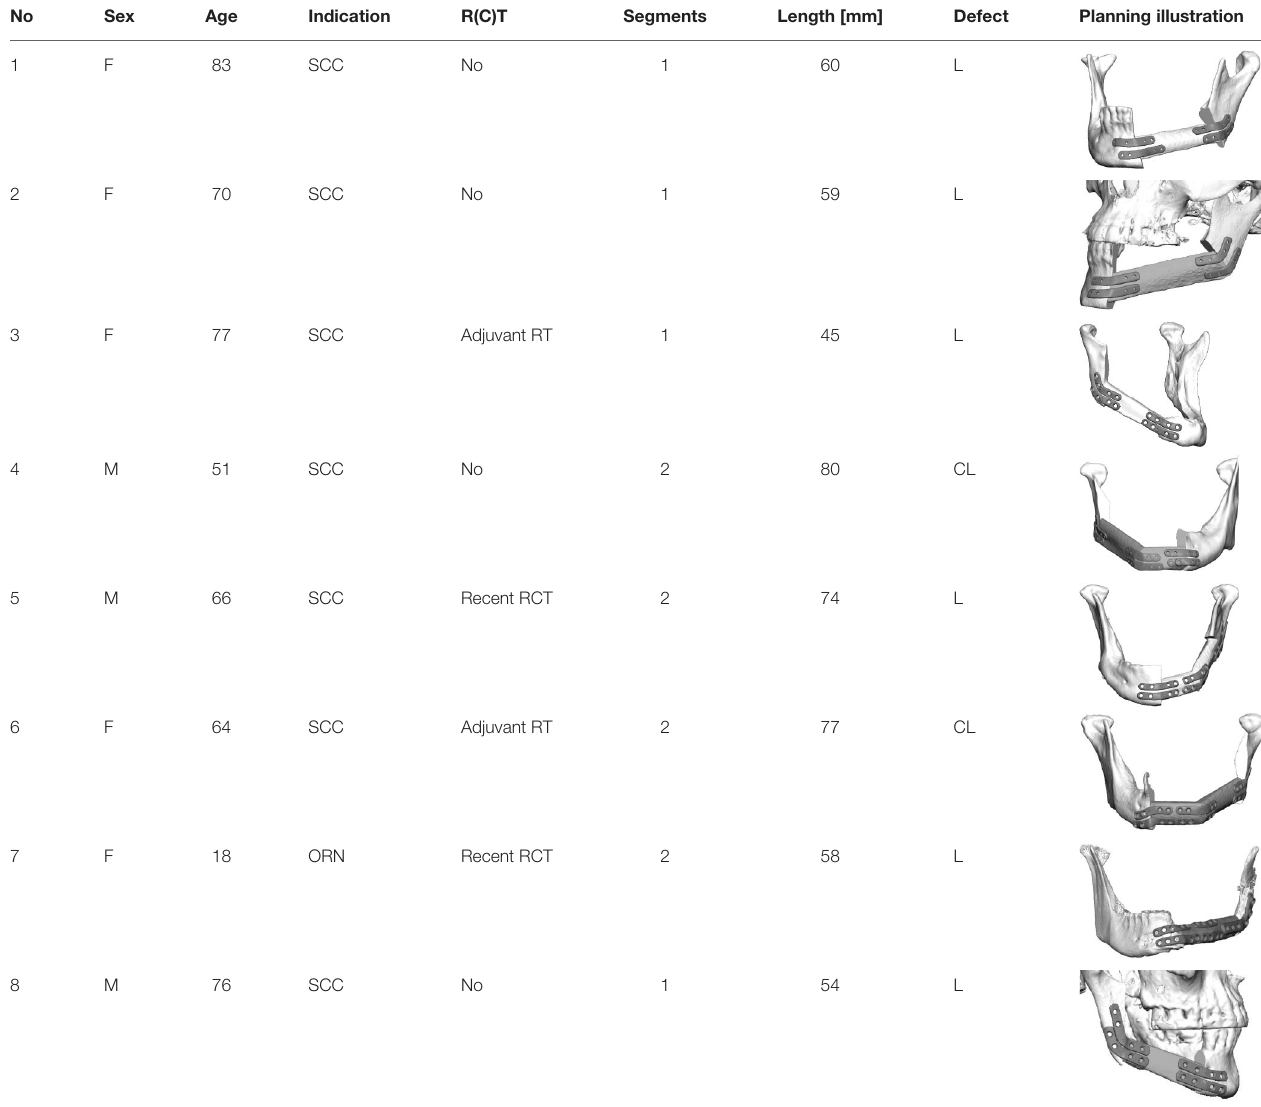
TABLE 1 | Patient characteristics; SCC, squamous cell carcinoma; ORN, osteonecrosis/late-onset flap loss; R(C)T, radio(chemo)therapy. Age Indication Segments Length [mm] Defect Planning